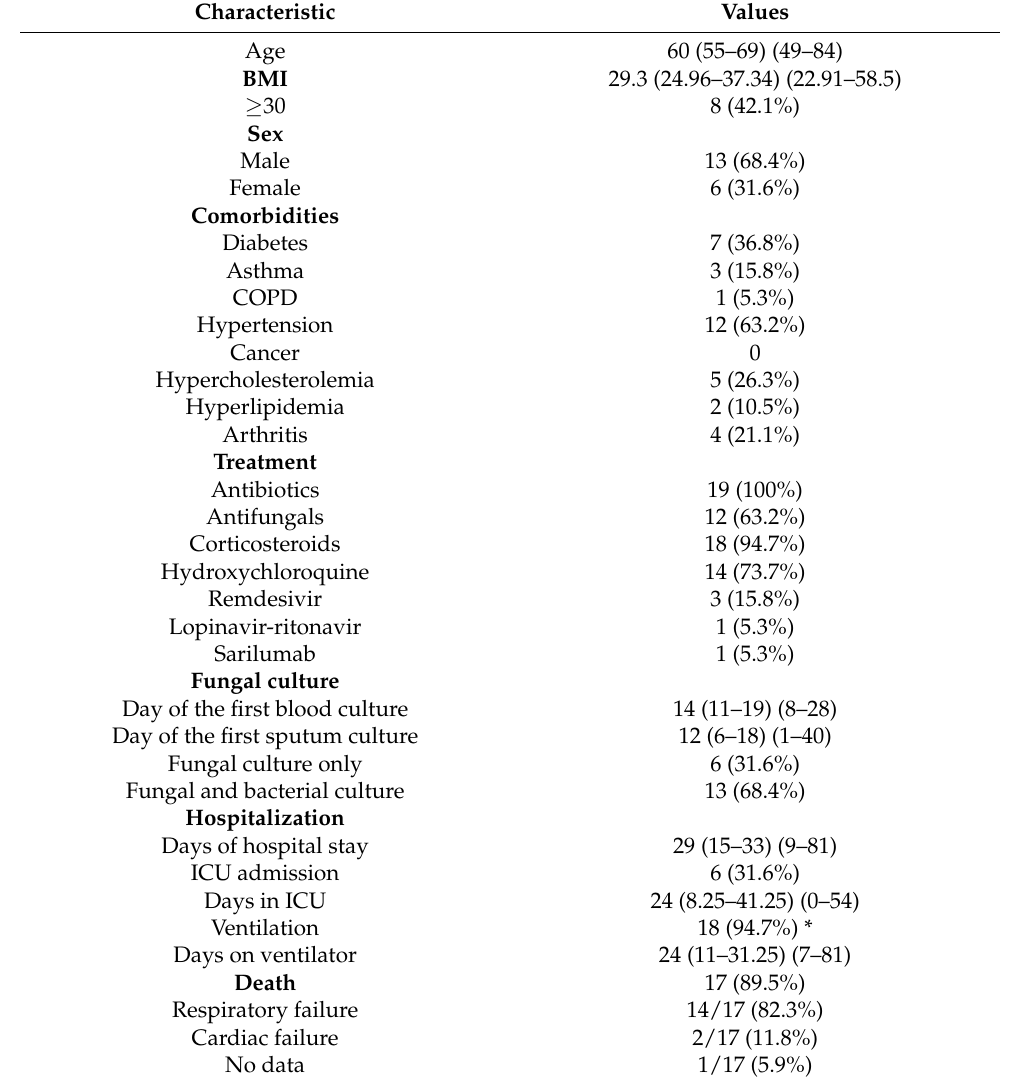
Table 4. The main characteristics of patients whose fungal isolates were recovered from data and are shown as median (IQR) [range] or n